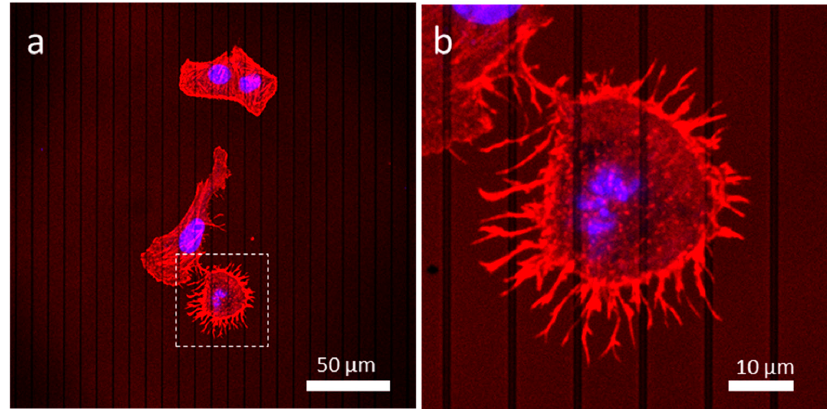
Figure 7. ( a ) Low magnification of a dividing cell possibly in the prophase on the structure containing alternating 9 µm tungsten lines and 1 µm silicon oxide lines. ( b ) High magnification image shows actin filaments protruding from the bottom half of the dividing cell.